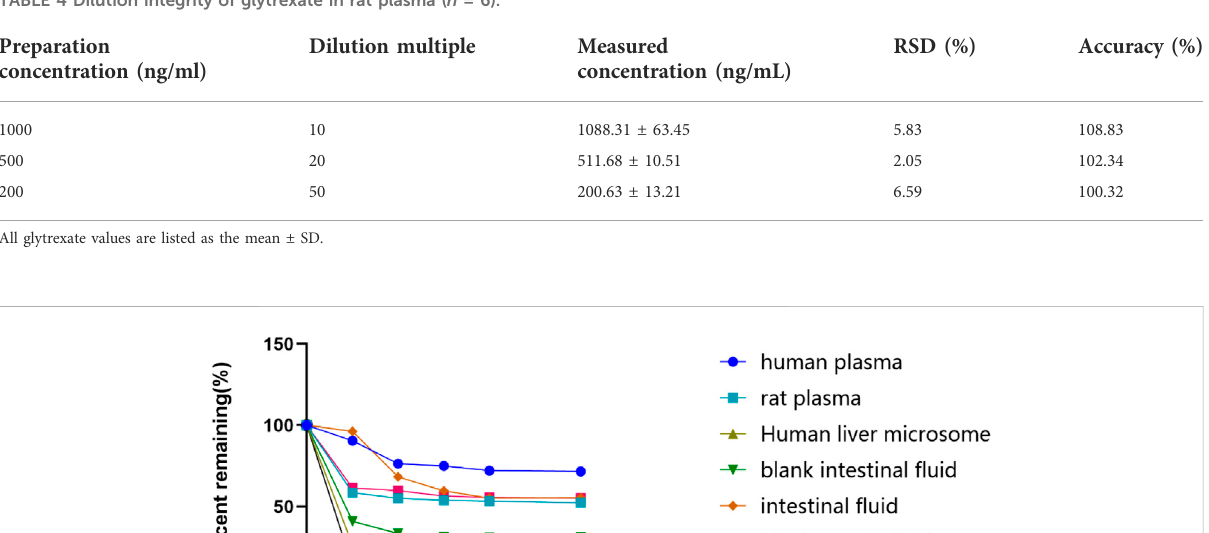
TABLE 4 Dilution integrity of glytrexate in rat plasma ( n = 6).